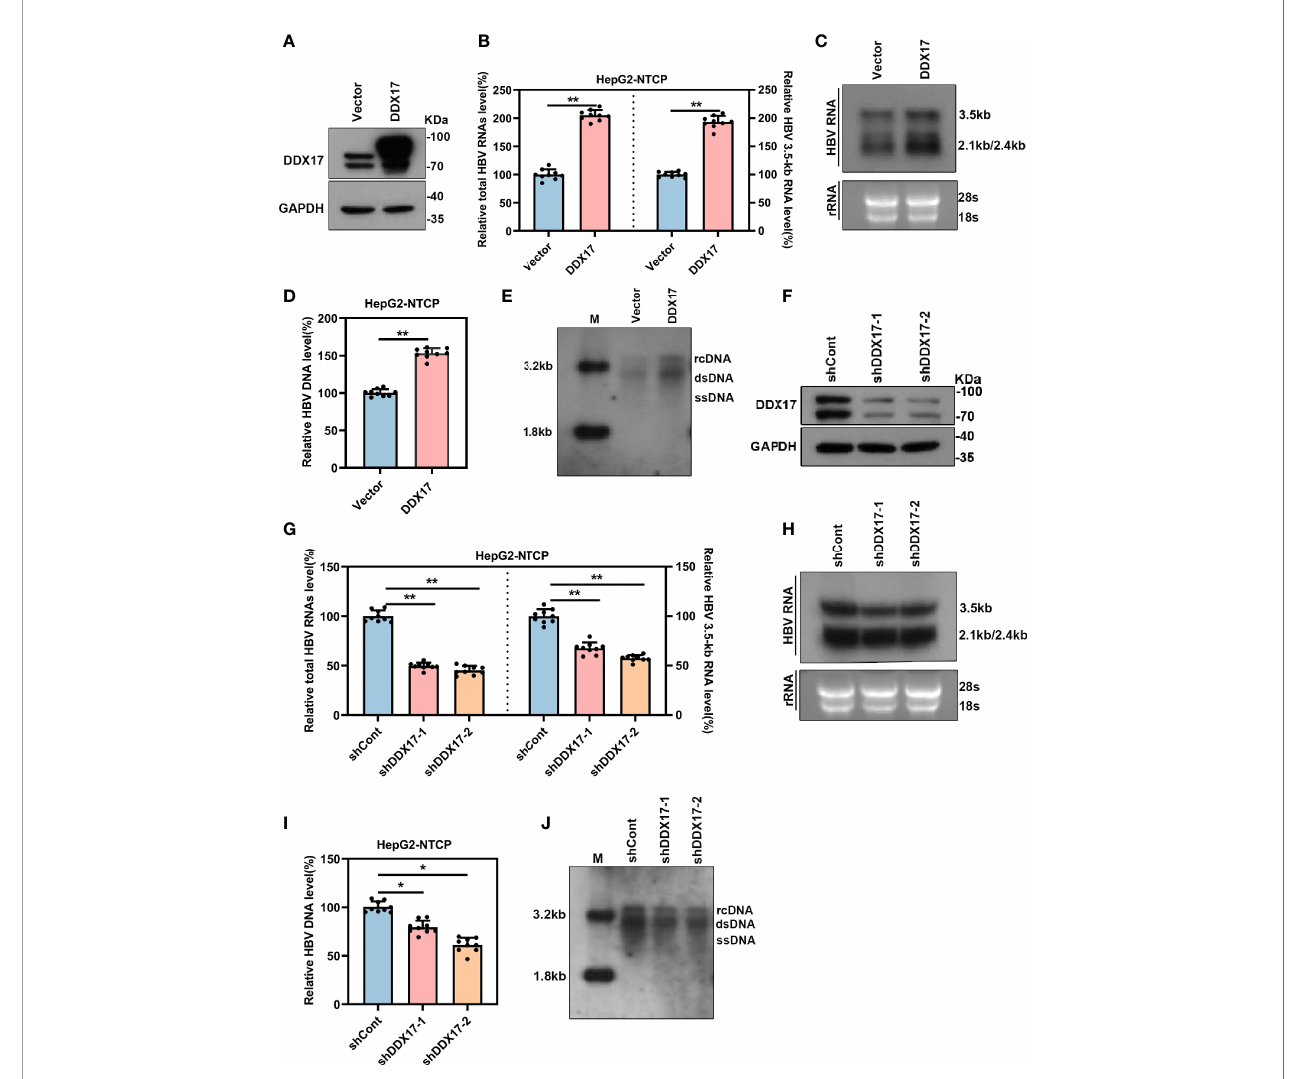
FIGURE 4 | The expression of DDX17 regulates HBV transcription and replication. The vector or DDX17 plasmids and lentivirus expressing shRNA targeting DDX17 or shCont transfected into HepG2-NTCP cells that were infected with 1,000 genome equivalents/cell of HBV particles in the presence of 4% PEG8000 for 24 h. Total HBV RNAs, 3.5-kb RNA, and HBV DNA were analyzed at day 5 after plasmid transduction. (A) The expression of DDX17 after transfected with plasmid expressing DDX17 and empty vector in HBV-infected HepG2-NTCP cells were access by using Western blot assay. GAPDH was used as the